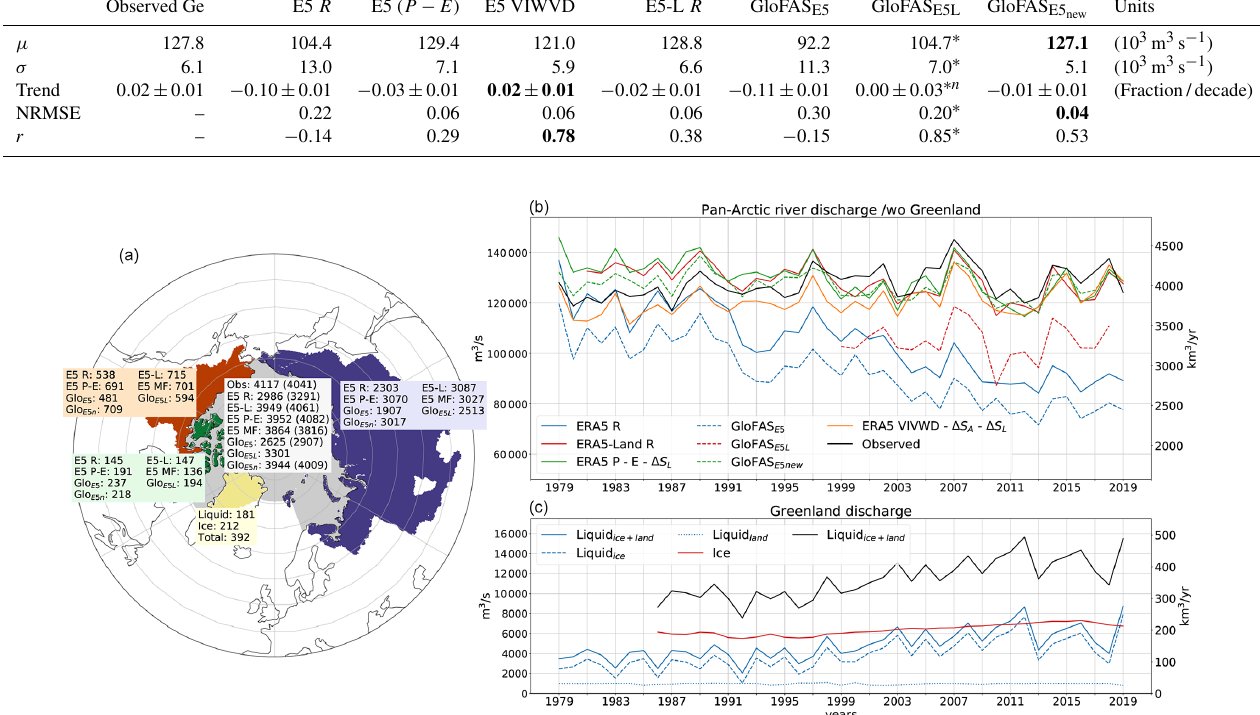
Figure 6. Panel (a) shows the drainage area and mean annual discharge values in km 3 yr − 1 for the whole area as well as for Eurasia, North America, and the CAA individually. Values are calculated over the coinciding period of all data sets 1999–2018 (values in brackets are calculated over the period 1981–2019). The observation-based estimate is calculated using correction factors for the ungauged areas from GLOFAS E5 . (b, c) Annual means of our observation-based estimate, ERA5, ERA5-Land, GLOFAS E5 , GLOFAS E5L , and GLOFAS E5 new runoff as well as indirectly calculated runoff through P − E and VIWVD for the period 1979–2019 (1981–2019 for ERA5-Land and 1999– 2018 for GLOFAS E5L ) are shown. Additionally, Greenlandic liquid (from land and ice; 1979–2019) and solid (1986–2019) discharges are displayed in panel (c)